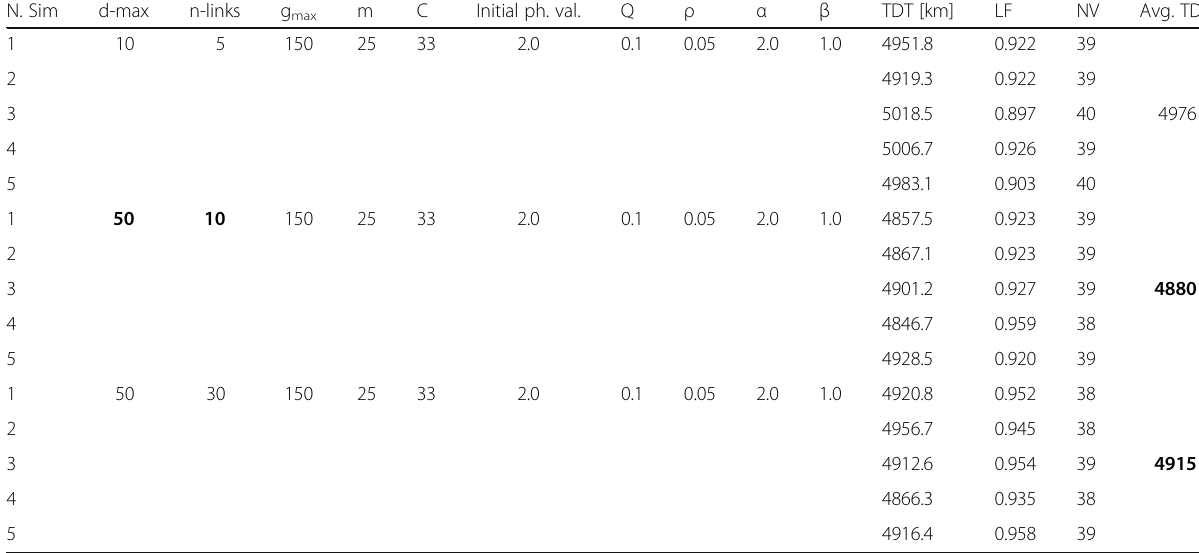
Table 1 Input parameters set and simulations results (day 1) N. Sim